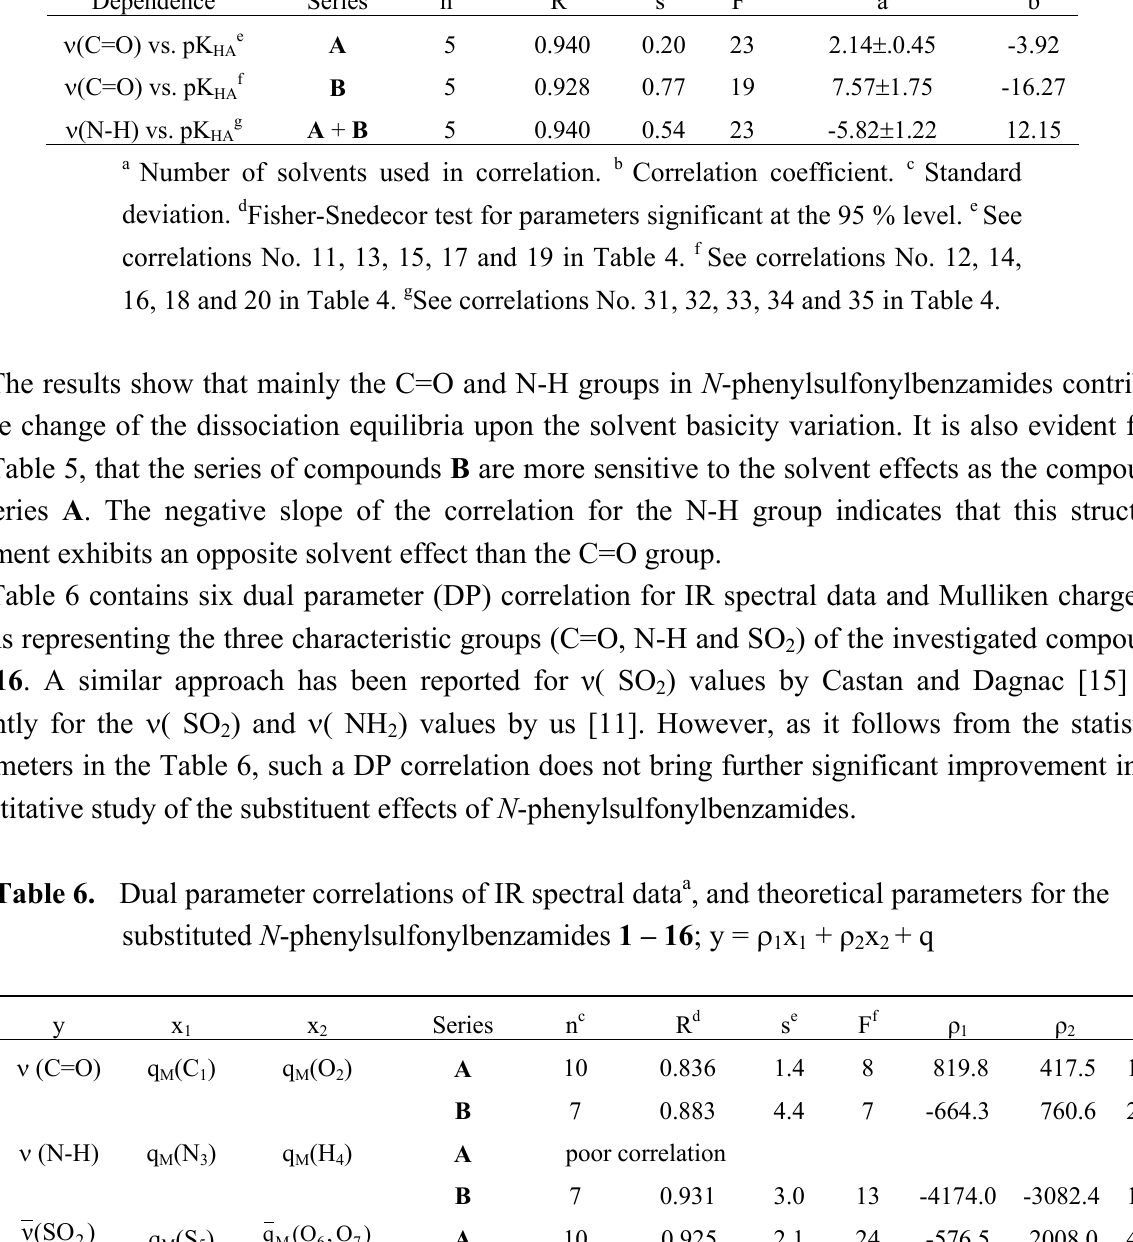
a Measured in CHCl . b Ordinal number of the correlations. c Number of compounds used 3 in correlation. d Correlation coefficient. e Standard deviation. f Fisher-Snedecor test for parameters significant at the 95 %